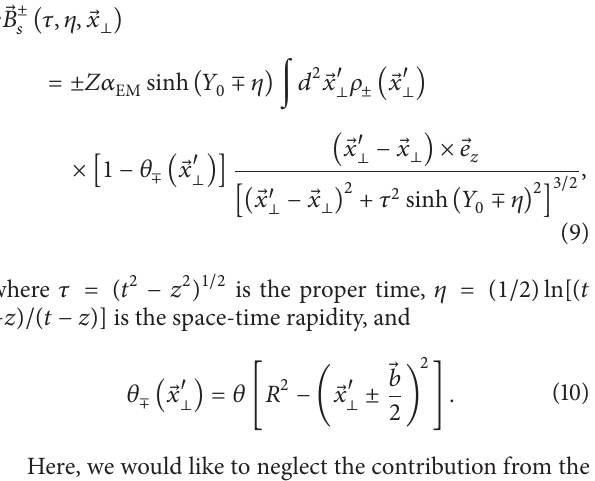
where 𝑛 0 = 0.17 fm